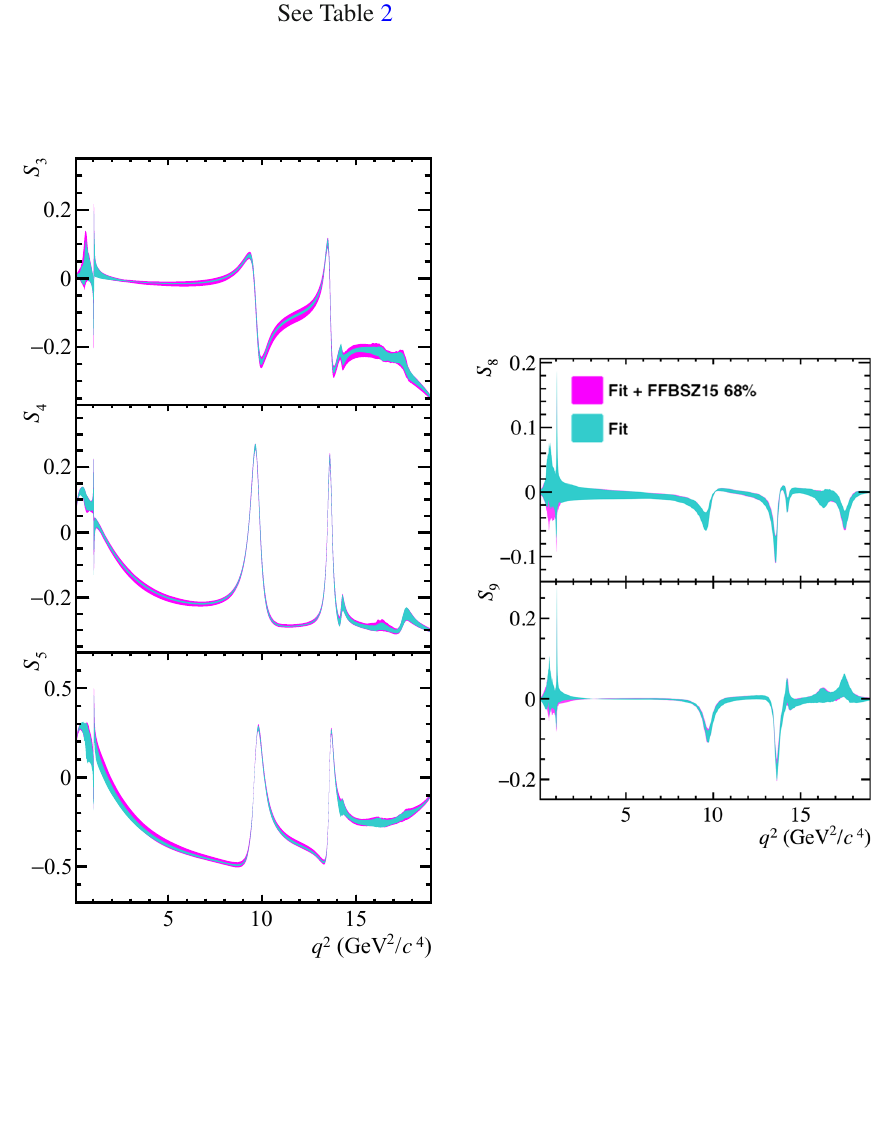
Table 2 Predictions of R K ∗ and R K at large and low recoil for differ- to be subdominant. In contrast, the 68% confidence interval of the R K . The interval for R K ∗ is determined using the model prediction is obtained using the measured long distance contributions ent values of C NP 9 μ describedinSect.2,consideringthefullvariationoftheunknownphases in B − → K − μ + μ − decays [20] θ 0 . The uncertainty due to the residual form factor dependence is found j = − 0 . 5 C NP = − 1 . Observable C NP 9 μ 9 μ